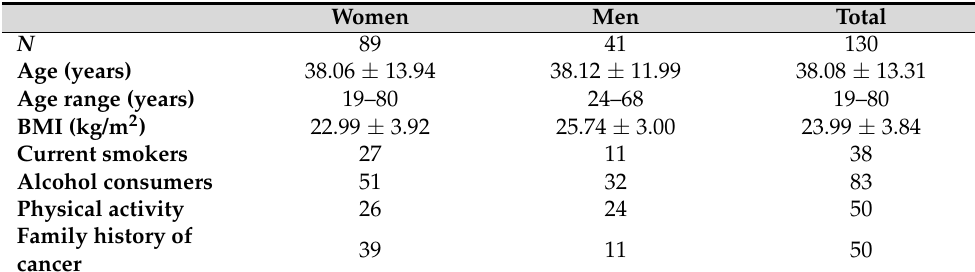
Table 1. Population characteristics and lifestyle factors of the study population (mean values ± stan- dard deviation of the mean).